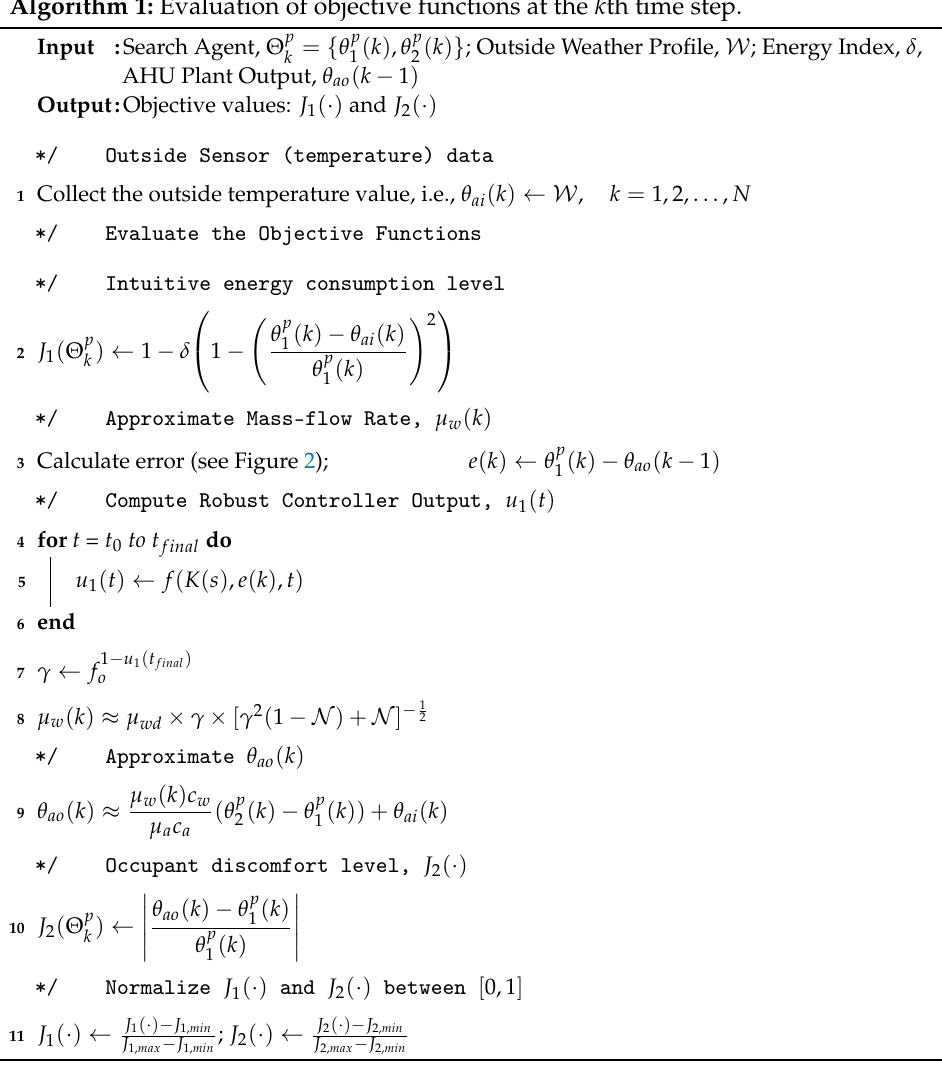
Algorithm 1: Evaluation of objective functions at the k th time